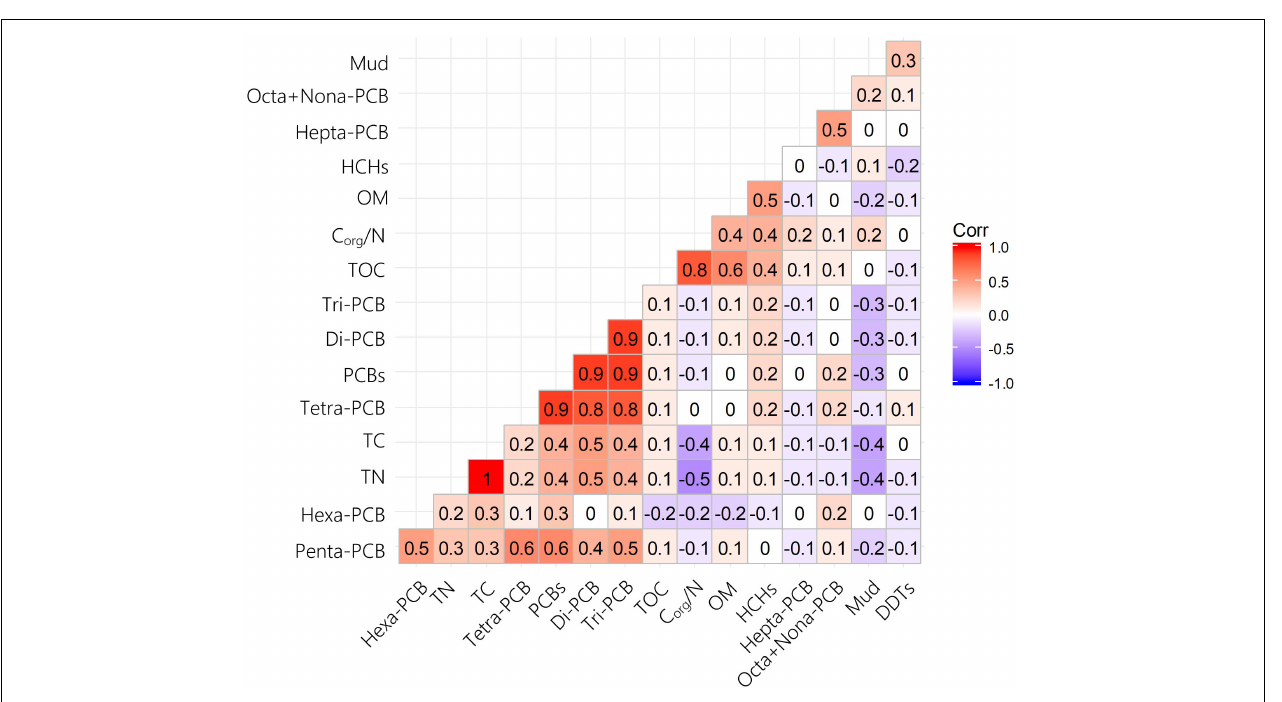
(0.06–1.91 ng g − 1 dw) and p,p (cid:48) -DDE (0.06–0.22 ng g − 1